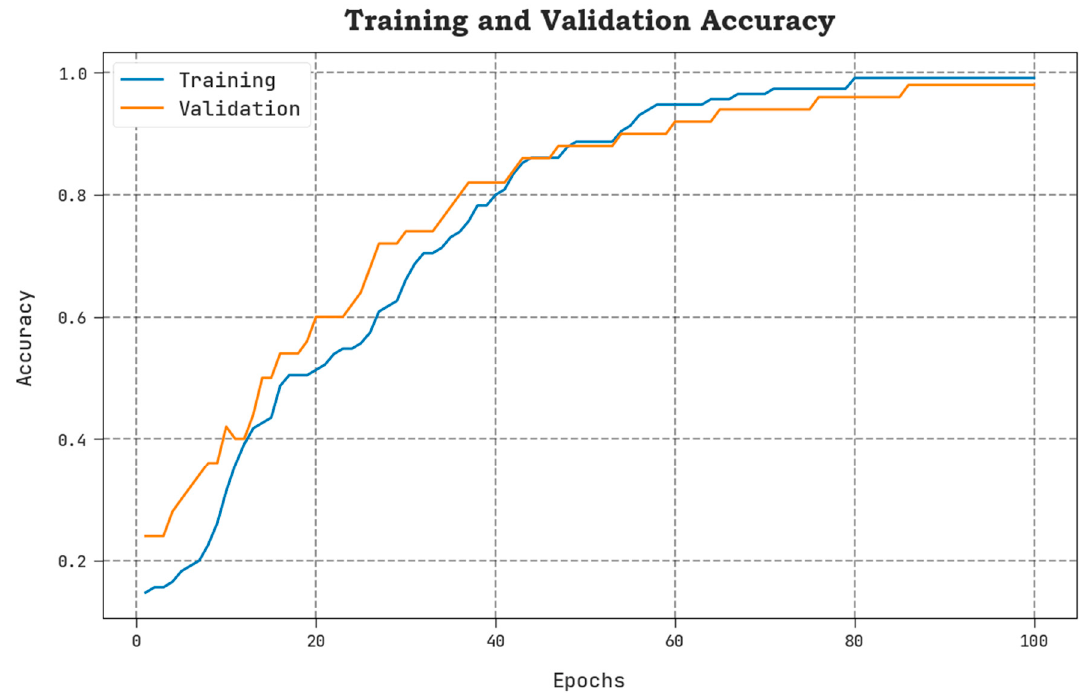
Figure 7. TACY and VACY analysis of the AAOXAI-CD approach on dataset-1.